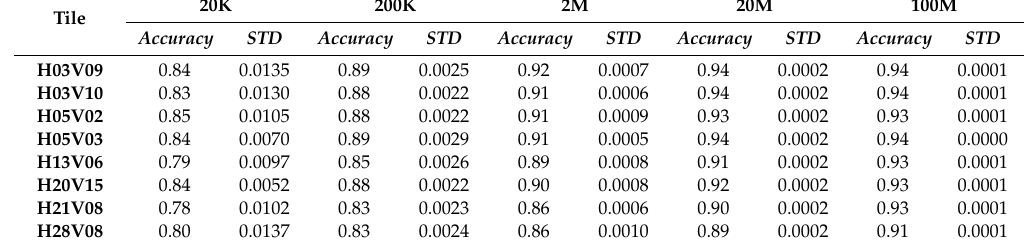
Table 3. The overall accuracy for a total of 20K, 200K, 2M, 20M, and 100M stratified training samples from National Land Cover Database (NLCD) 2001. The standard deviation is calculated from the accuracy through 10 iterations.